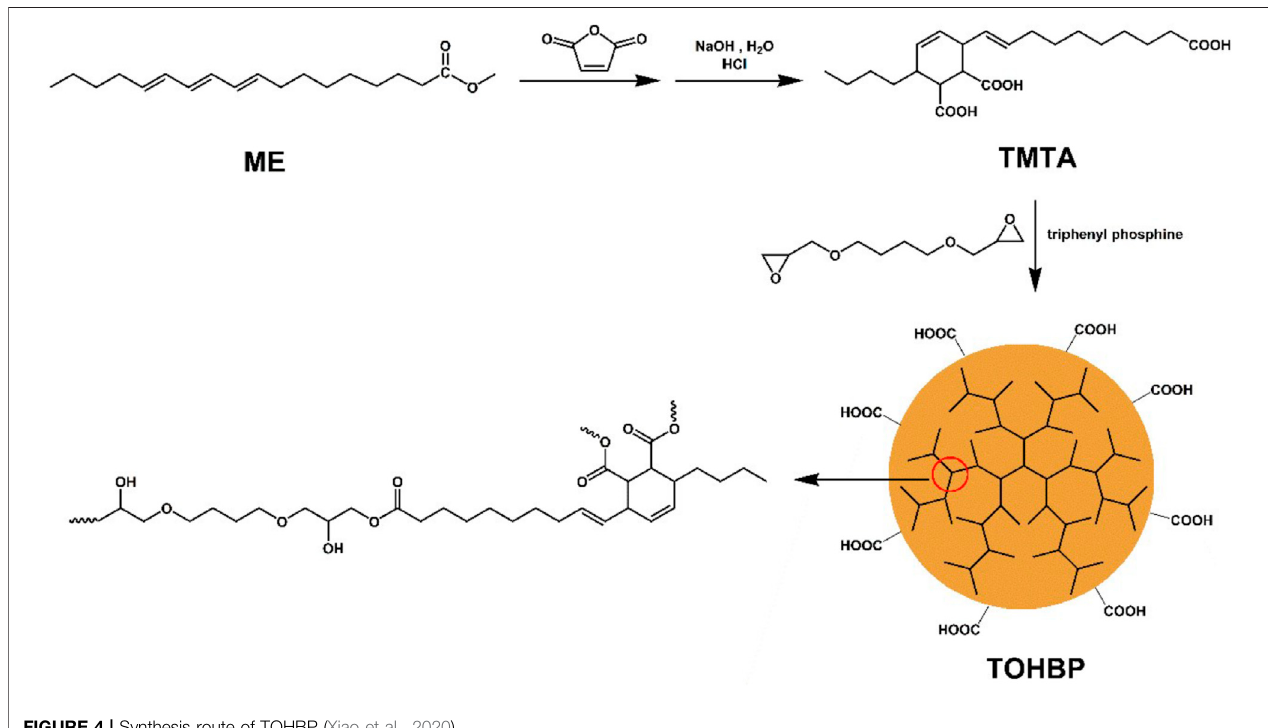
FIGURE 4 | Synthesis route of TOHBP (Xiao et al., 2020).